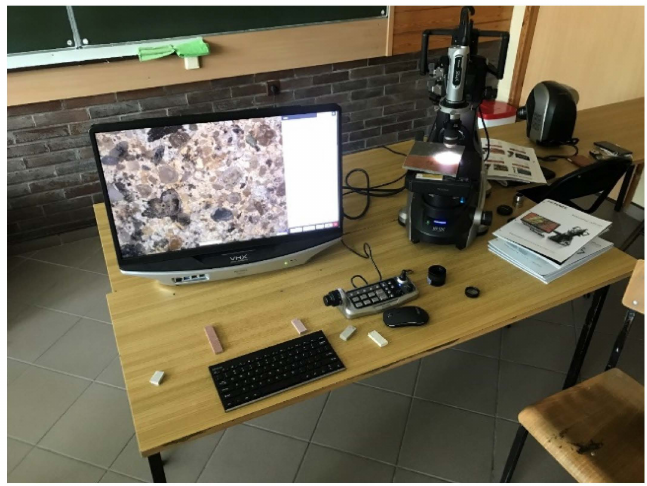
Figure 6. Keyence VH × -7000 series digital